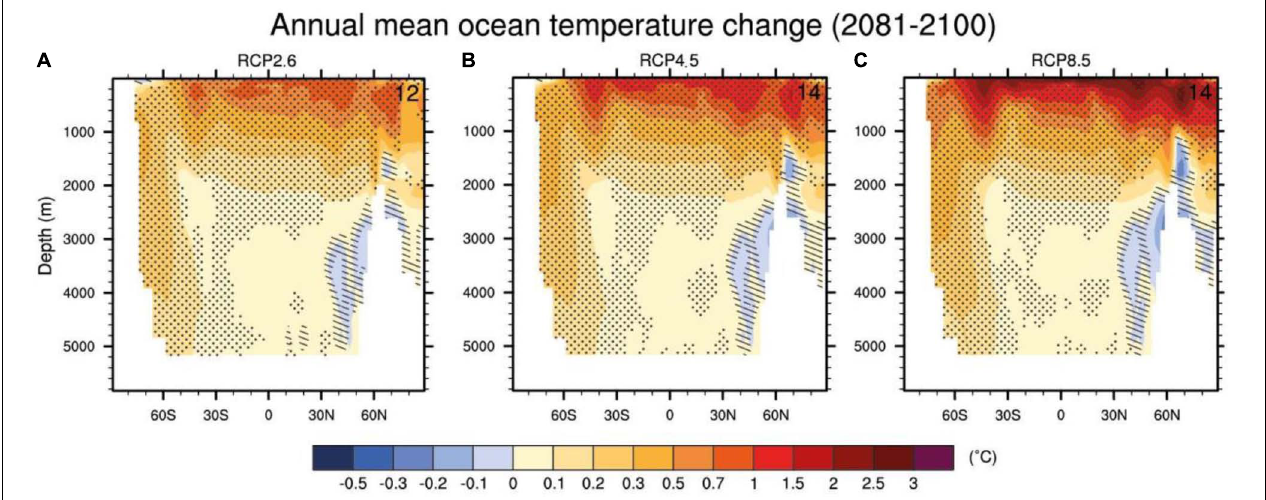
FIGURE 3 | CMIP5 multi-model changes in annual mean zonal mean temperature in the ocean relative to 1986–2005 for 2081–2100 under the RCP2.6 (A) , RCP4.5 (B) , and RCP8.5 (C) forcing scenarios. Hatching indicates regions where the multi-model mean change is less than one standard deviation of internal variability. Stippling indicates regions where the multi-model change mean is greater than two standard deviations of internal variability and where at least 90% of the models agree on the sign of change. The numbers in the upper-right corner indicate the size of the model ensemble. Reproduced from IPCC AR5 (Collins et al., 2013, Figure